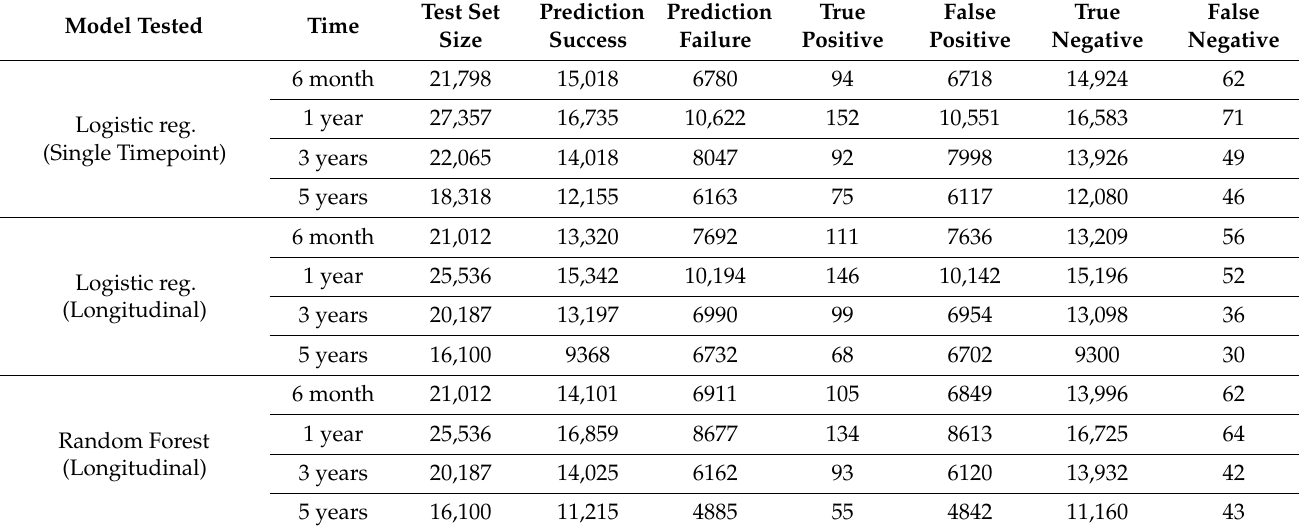
Table 3. Performance of models in the test